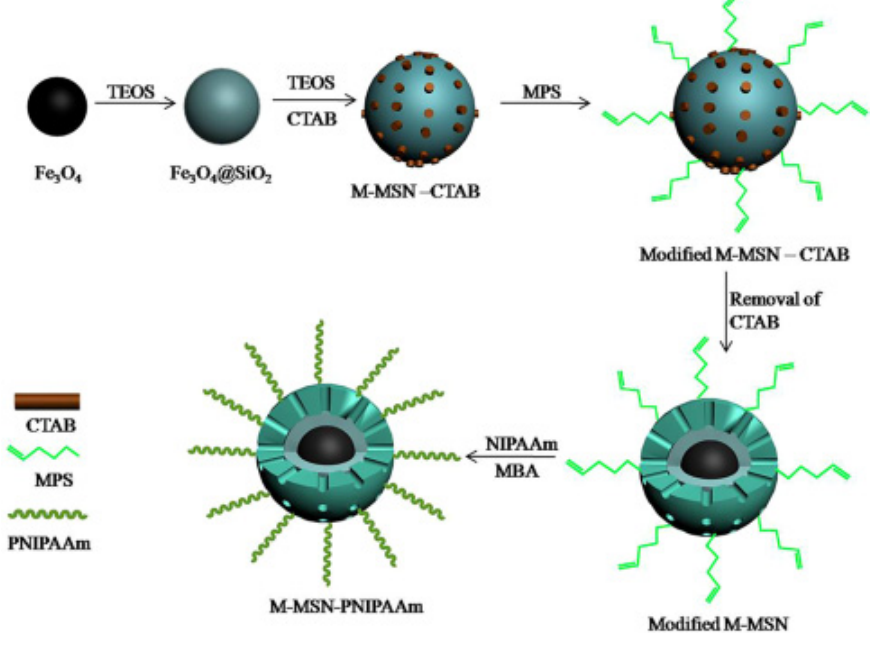
Figure 12. Schematic for the preparation process of M-MSN–PNIPAAm. Reproduced with permission from [108]. Copyright John Wiley and Sons,